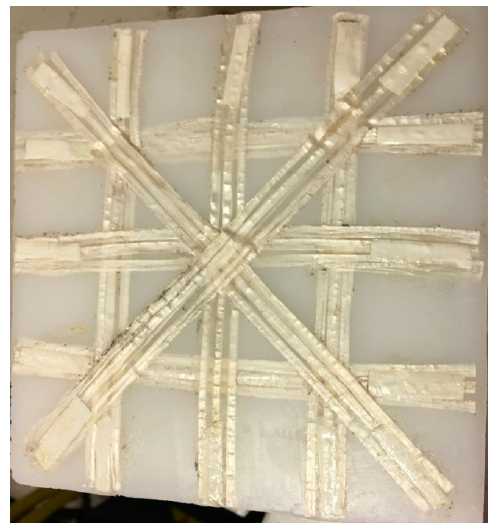
Figure 2. Picture of rotational molded homo-composite